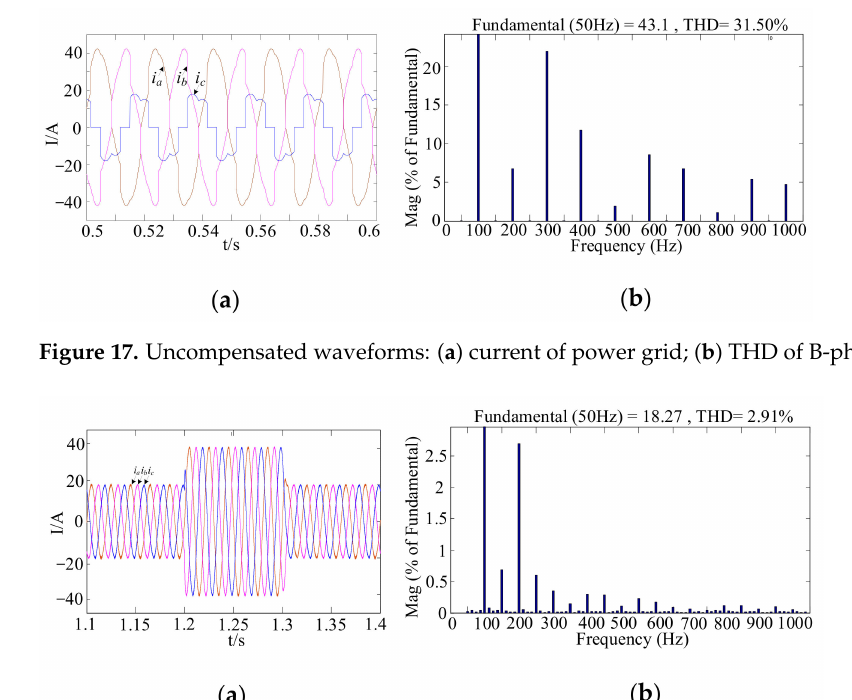
Figure 16. Topology of the unbalanced load.